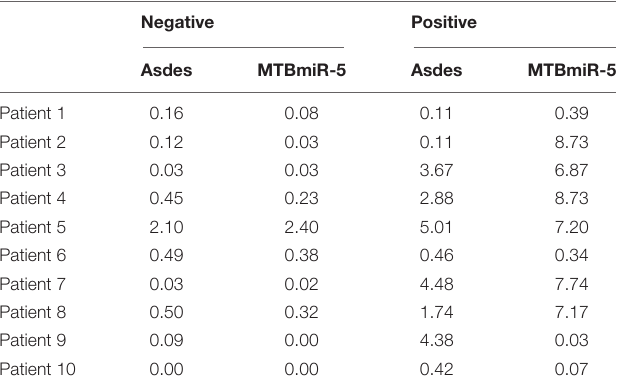
TABLE 2 | The expression level (pmol per 1 L of serum) of ASdes and MTB-miR5 in the small extracellular vesicles derived from serum of TB-infected patients with negative AFB smear staining and sputum culture at the first admission to the hospital and the second day after the result of AFB smear staining or/and sputum culture changed